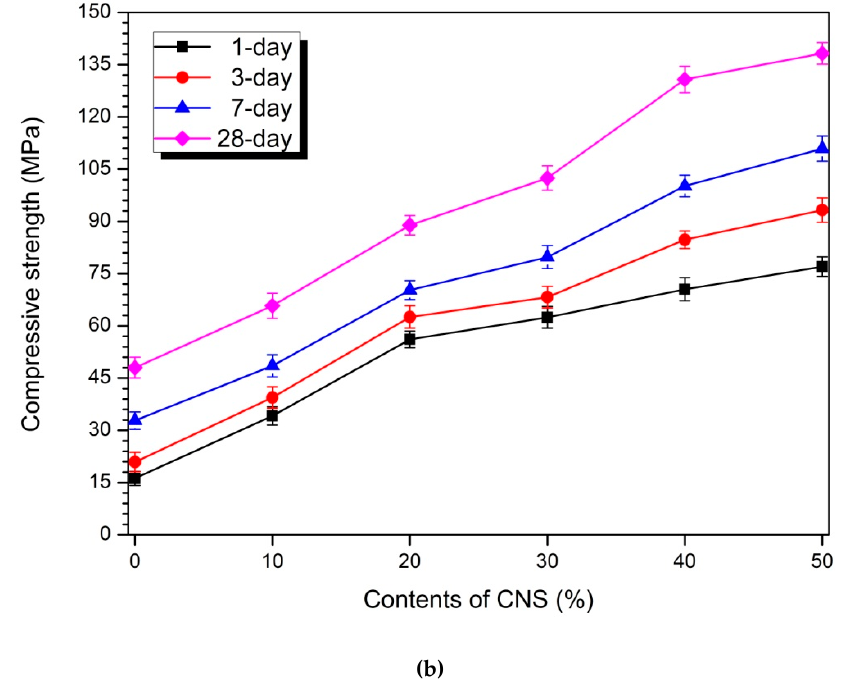
Figure 4. Compressive strength: ( a ) 5% activator and ( b ) 10% activator samples. Table 3 calculates the compressive strength increase rate of CNS substituted samples for 0% CNS.